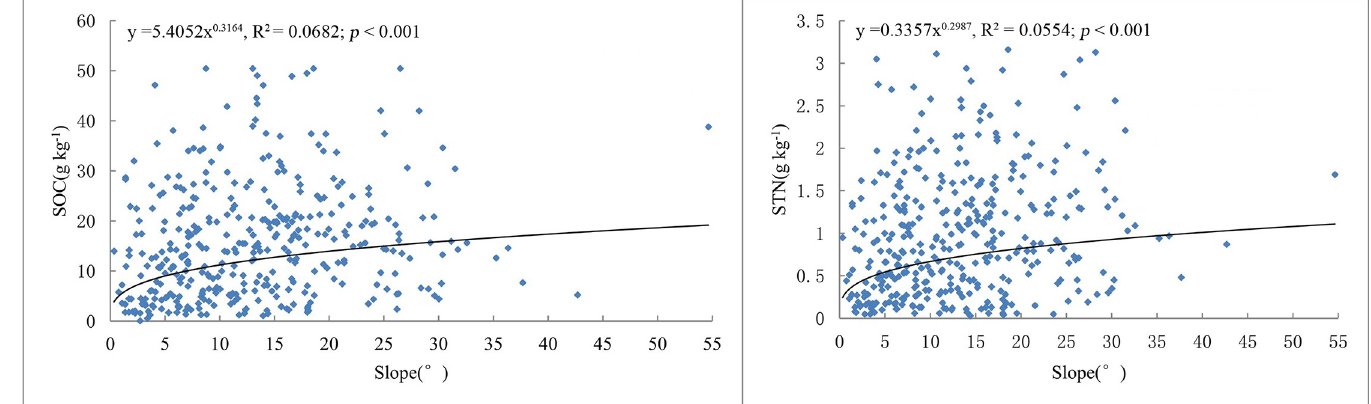
Fig 6. Regression analysis between the SOC, STN and slope using scatter plots.